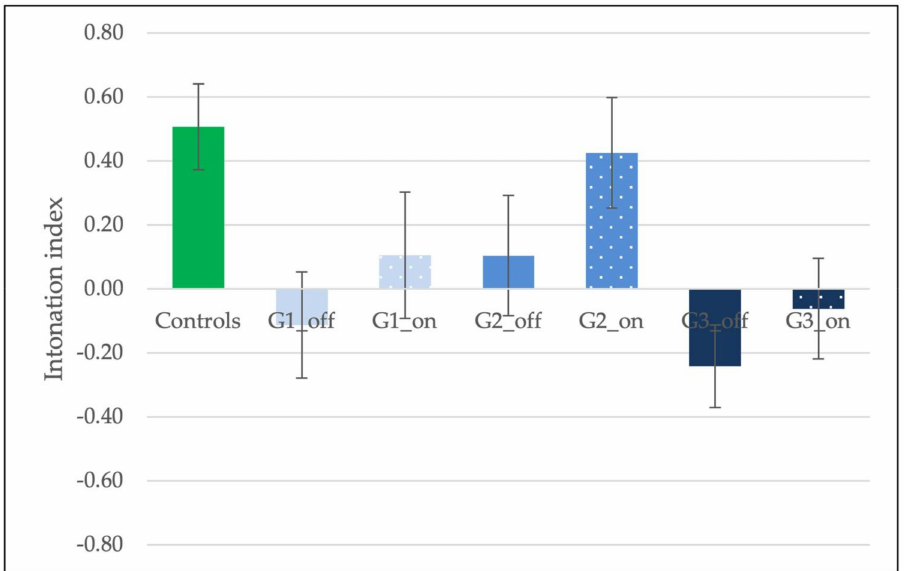
Figure 4. Average intonation index across groups (Controls, and the three groups of patients, G1, G2, and G3) and medication conditions (medication-OFF and medication-ON). Error bars indicate the standard error of the mean ( ±